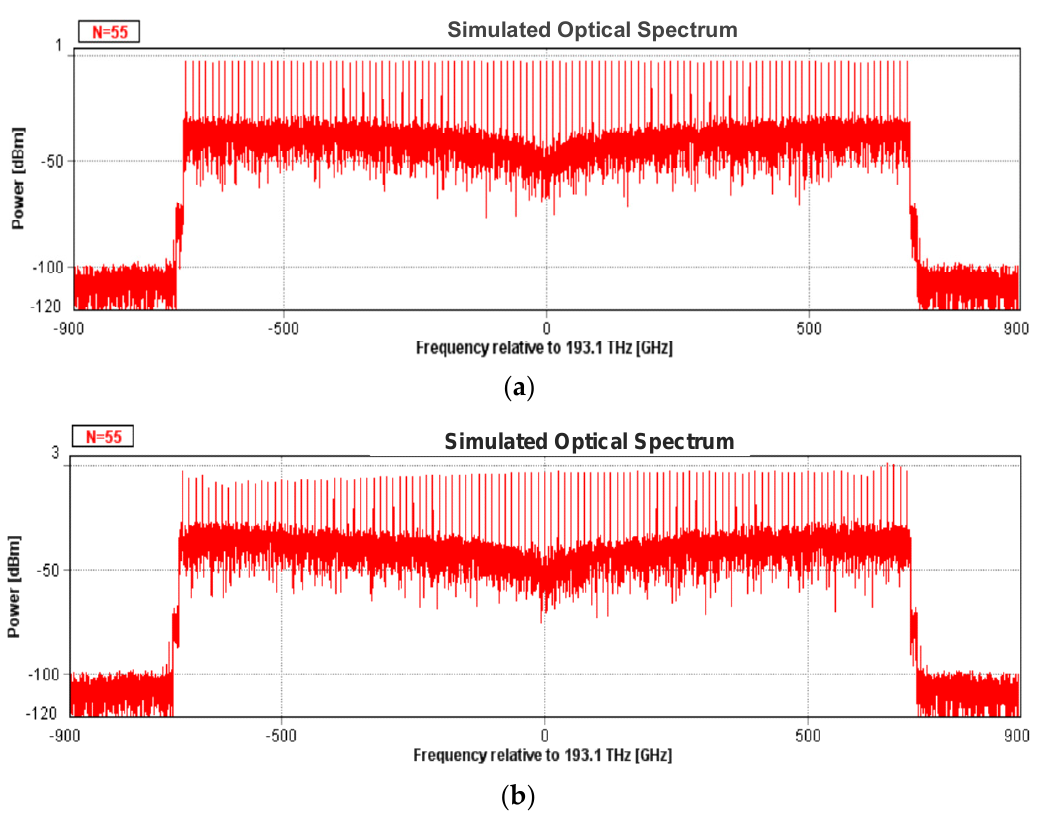
Figure 3. 111-line optical frequency comb: ( a ) with TODL in the loop; ( b ) without TODL in the loop.